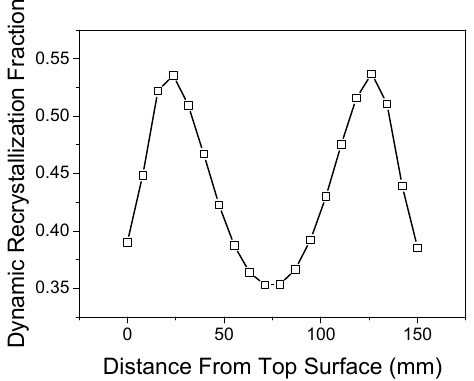
Figure 7. The distribution of dynamic recrystallization fraction.